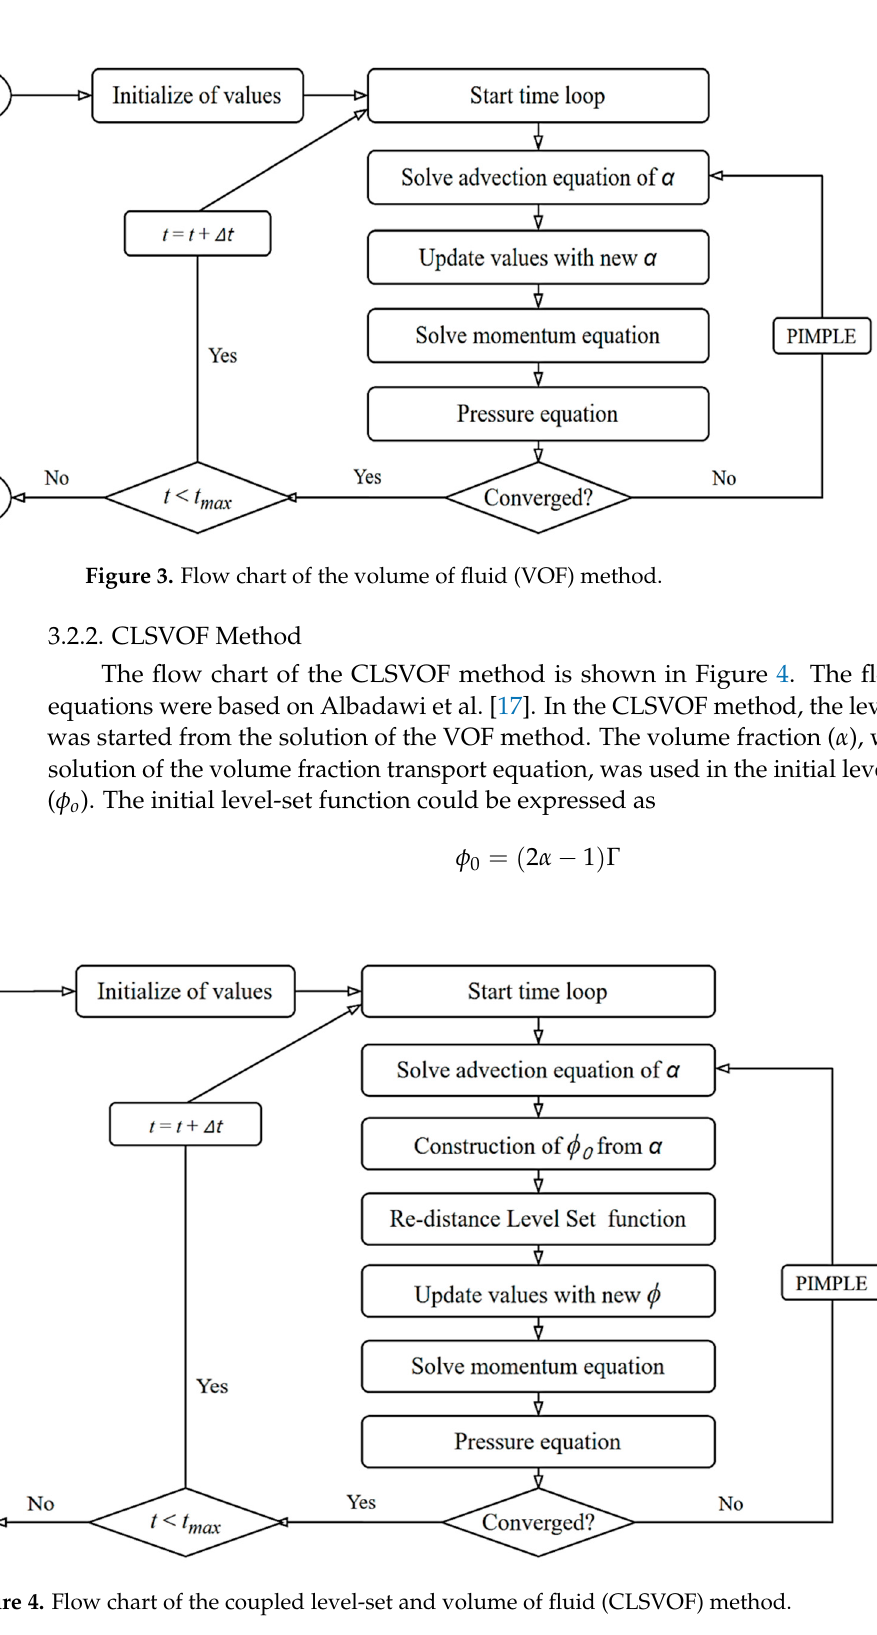
Figure 4. Flow chart of the coupled level-set and volume of fluid (CLSVOF) method.